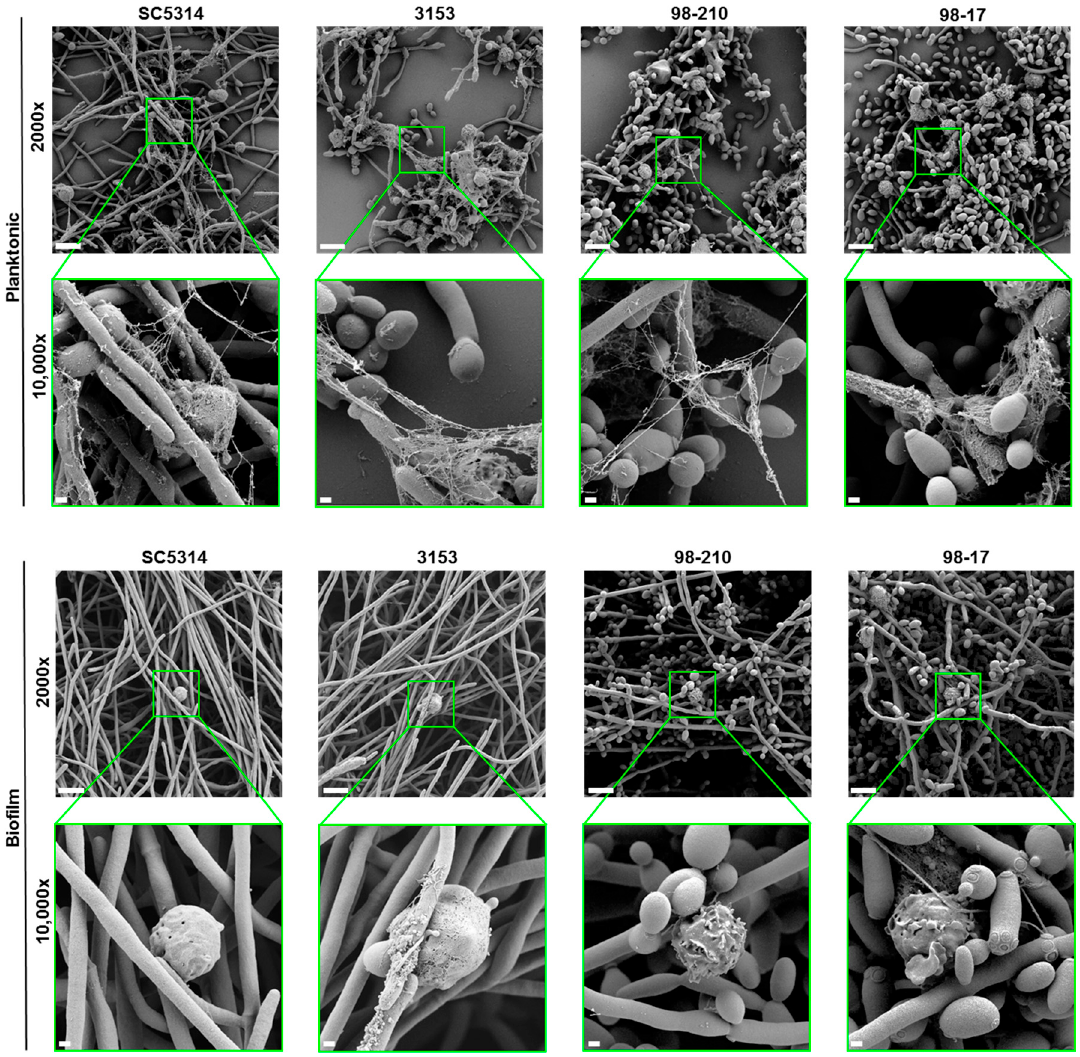
Figure 5. Scanning electron microscopy of neutrophils exposed to planktonic cells or biofilms of C. albicans clinical isolates for 4 h. Measurement bars represent 10 μ m and 1 μ m for images taken at 2000× and 10,000×, respectively.